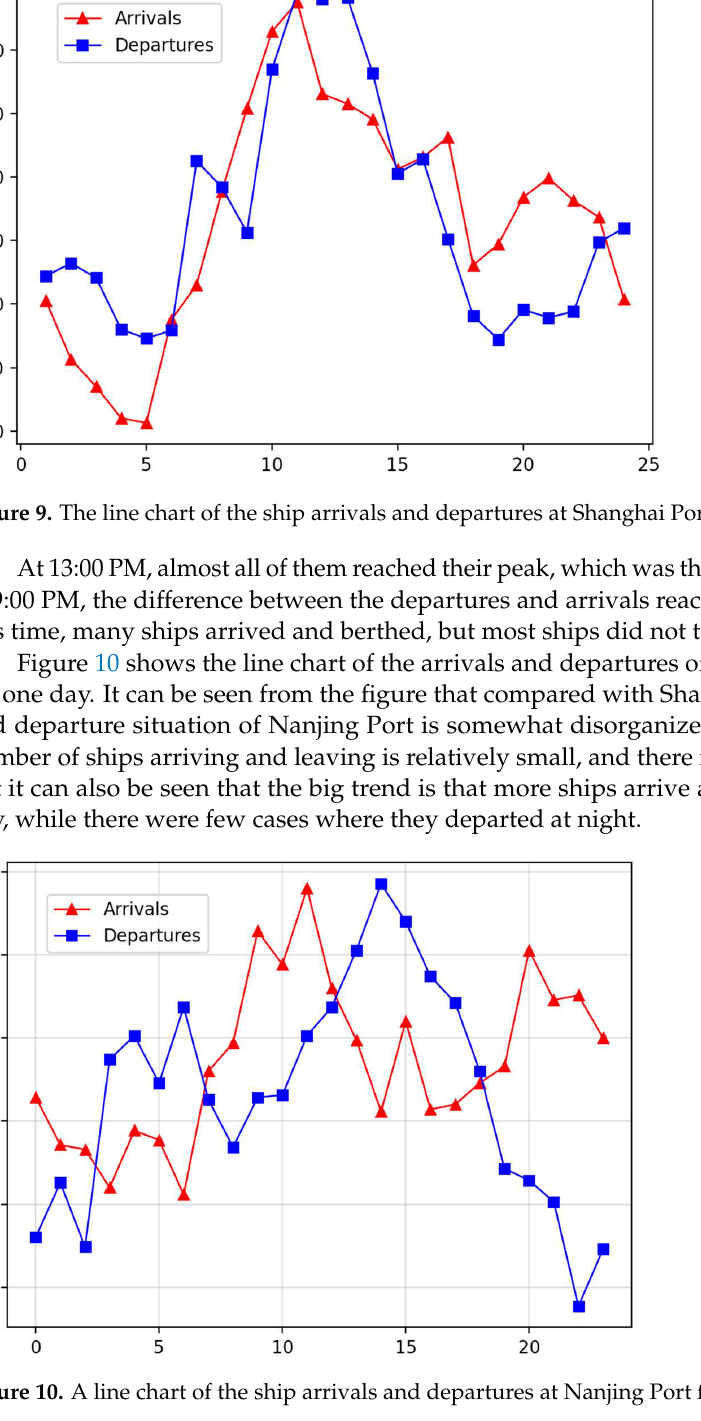
Figure 10. A line chart of the ship arrivals and departures at Nanjing Port for one day.